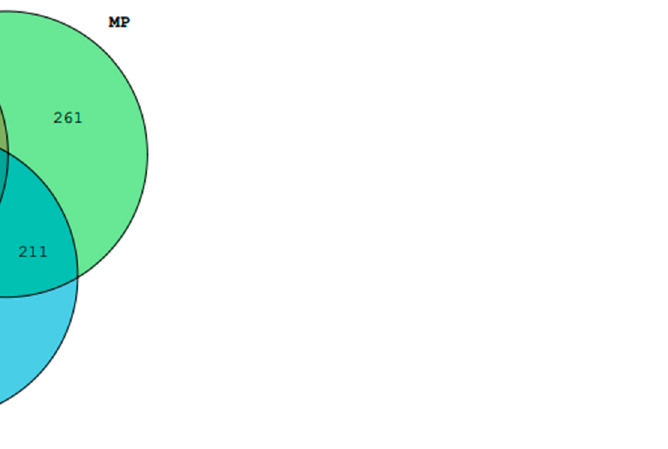
Figure 1. Shared operational taxonomic unit (OTU) analysis of different groups (the low dietary protein group (LP), moderate dietary protein group (MP), high dietary protein group (HP)).